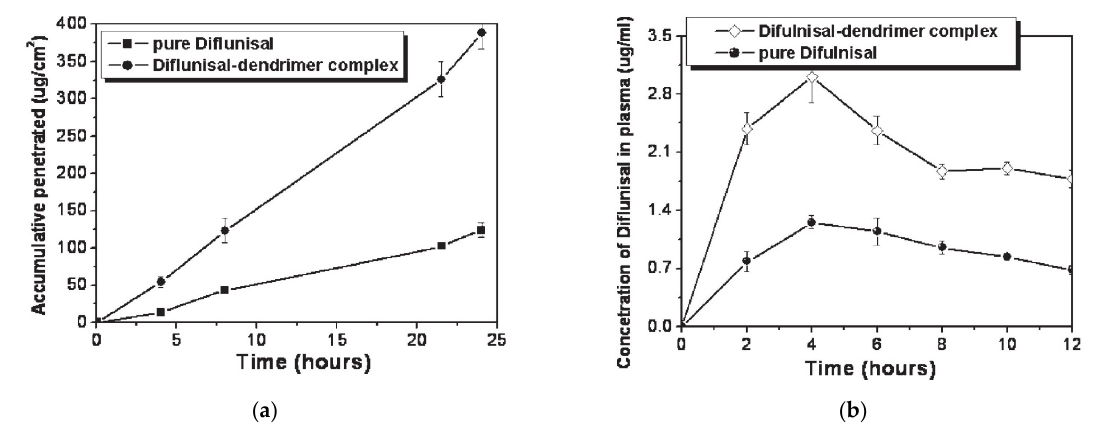
Figure 20. ( a ) Accumulative amount of diflunisal permeated through rat skin from pure diflunisal dispersed in saline solution ( ◼ ) and aqueous solution of a drug–dendrimer complex ( ● ); ( b ) diflunisal concentration in animal plasma after treatment of pure di fl unisal ( ● ) and di fl unisal–dendrimer complexes ( ◇ ). Reproduced from [72], with permission from Elsevier, 2021.